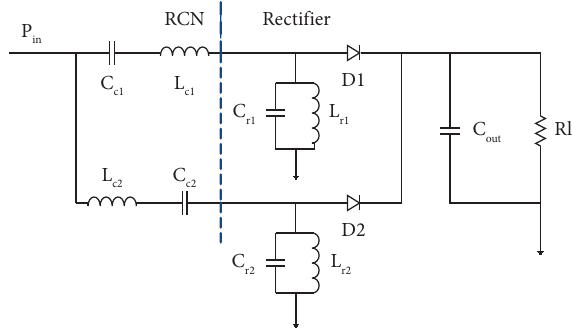
Figure 3: Converter incorporating a resistance compression network.